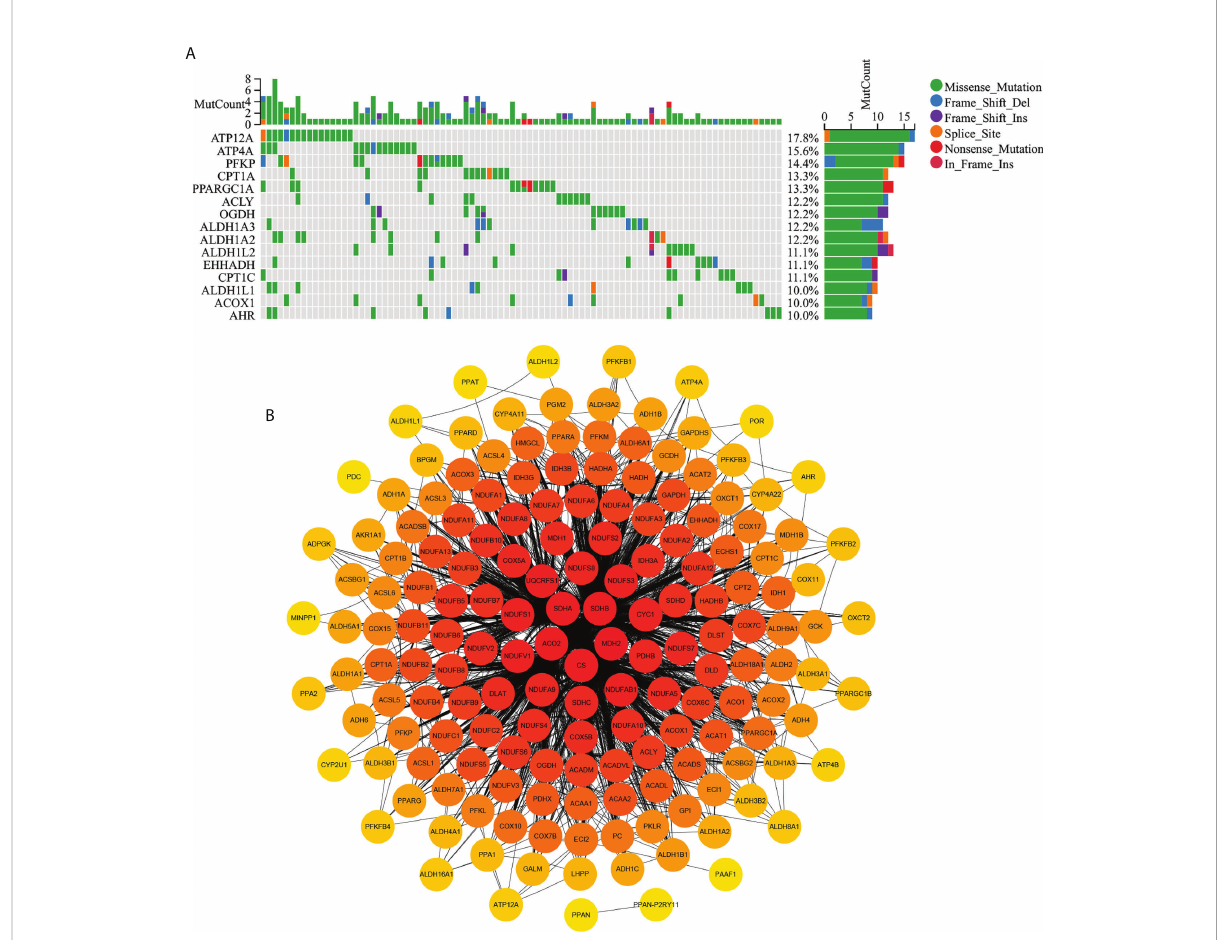
FIGURE 2 Map of MMRG gene mutation and protein interaction in COAD. (A) The fi rst 15 MMRGs mutated in COAD. (B) MMRG protein interaction diagram; the darker the red, the more critical the protein